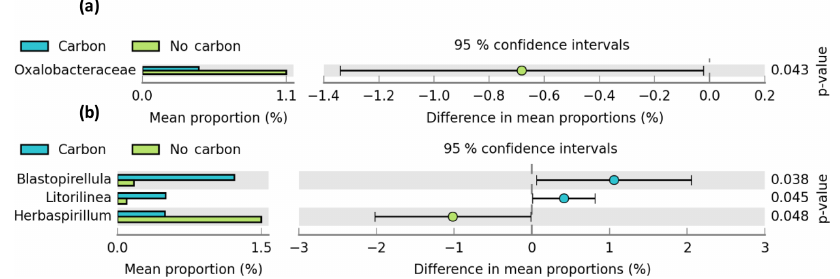
Figure 5. The mean proportion (%) and the difference in the mean proportion of taxa at (a) family and (b) genus level between + C and − C treatments with 95% confidence intervals. Significant differences in mean proportions were determined using two-sided Welch’s t tests (alpha = 0.05). Table 2. Results of a PERMANOVA testing the differences in microbial community structure at the five sediment depths prior to the addition of aquaculture waste (In) and after waste addition, both with and without carbon supplementation. d f Sum of squares Mean F R 2 p squares model Treatment ( T ) 2 0.797 0.399 1.195 0.058 0.115 Sediment depth ( D ) 4 1.705 0.426 1.278 0.123 0.011 T × D 8 2.656 0.332 0.996 0.192 0.494 Residuals 26 8.672 0.334 0.627 Total 40 13.830